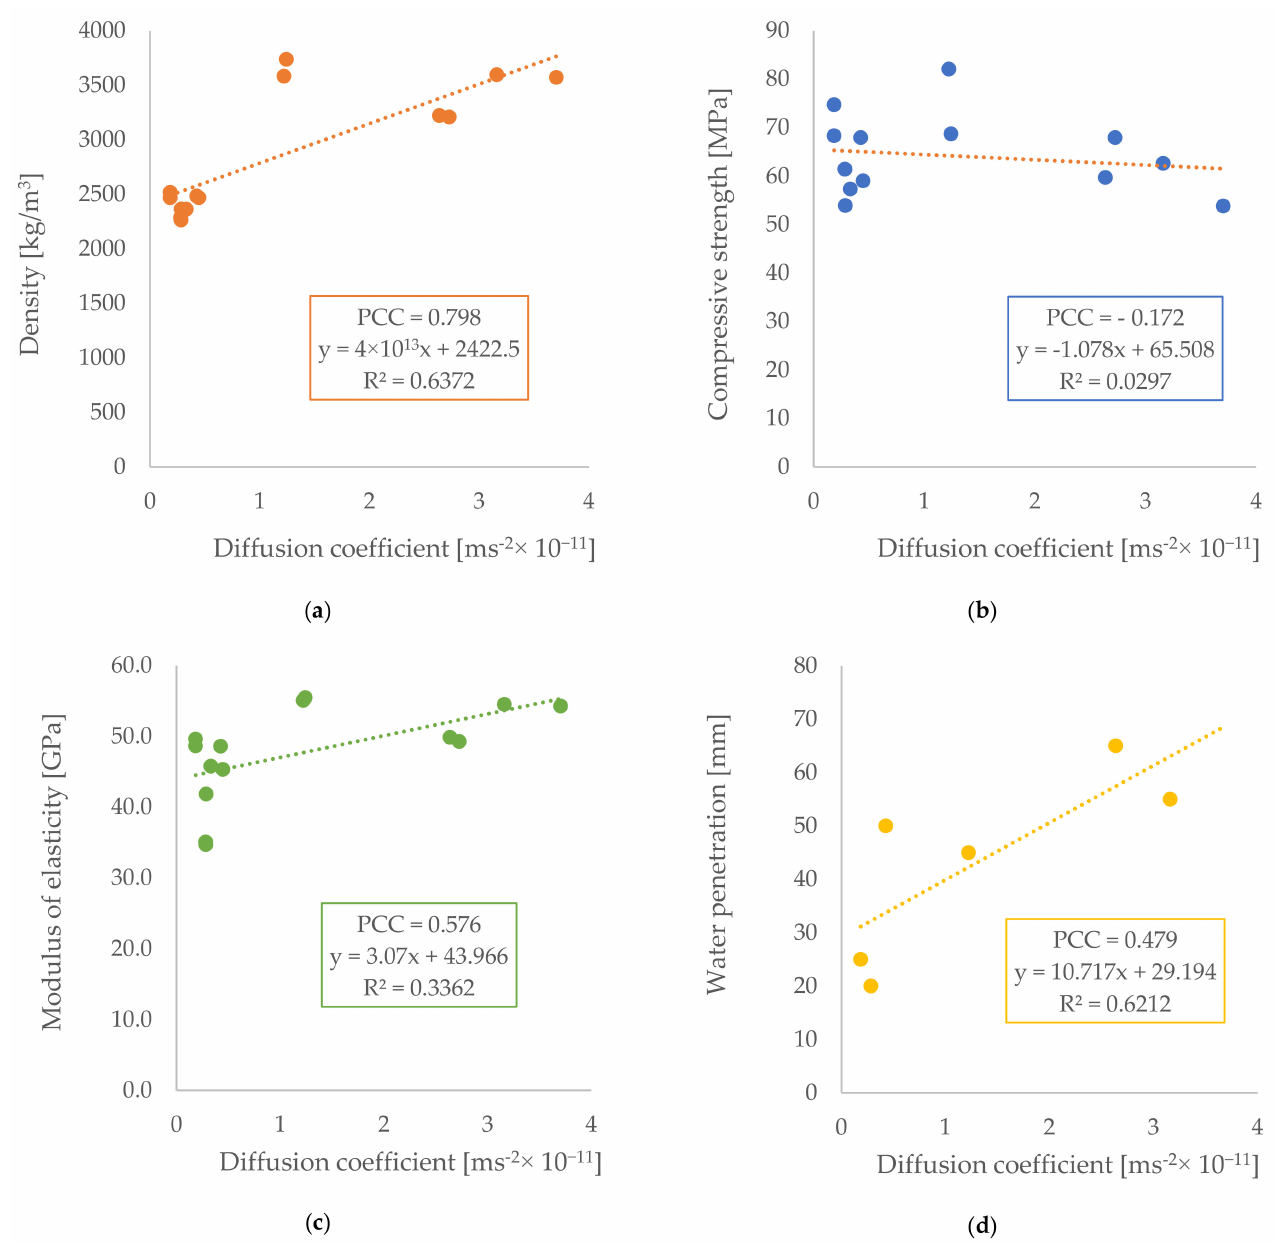
Figure 7. Correlation between the diffusion coefficient and: ( a ) density, ( b ) compressive strength, ( c ) modulus of elasticity, and ( d ) water